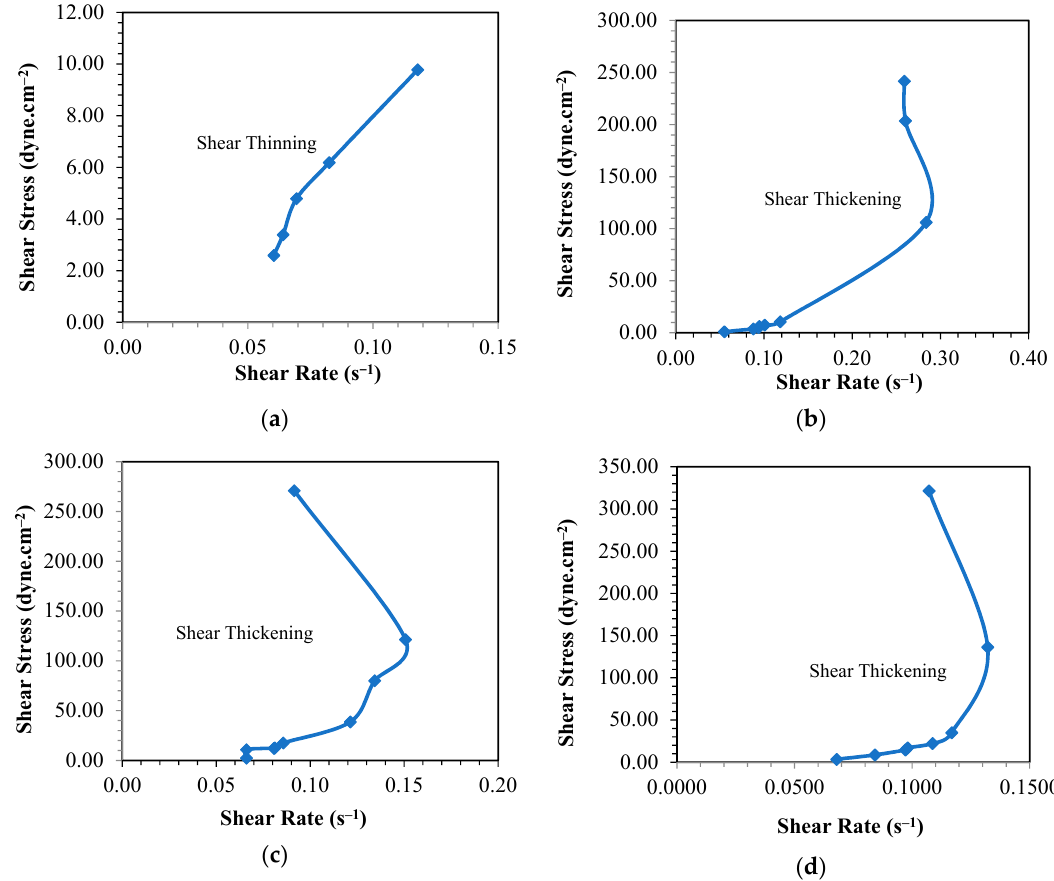
Figure 6. Curve of shear rate—shear stress for phenol formaldehyde (PF) resin (PF I) synthesis temperature at ( a ) 40, ( b ) 60, ( c ) 80 and ( d ) 100 °C.